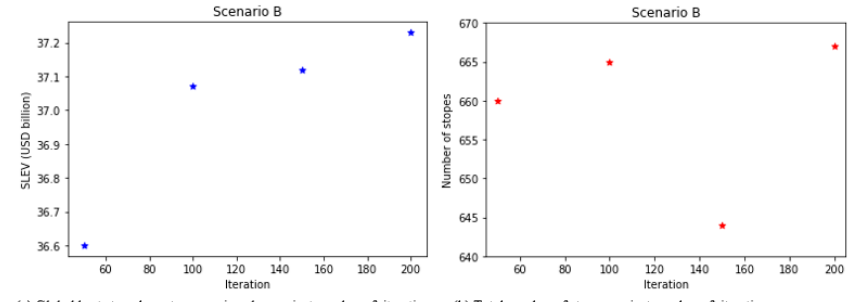
Figure 10. Scenario B: optimisation results of SLEV and number of stopes.